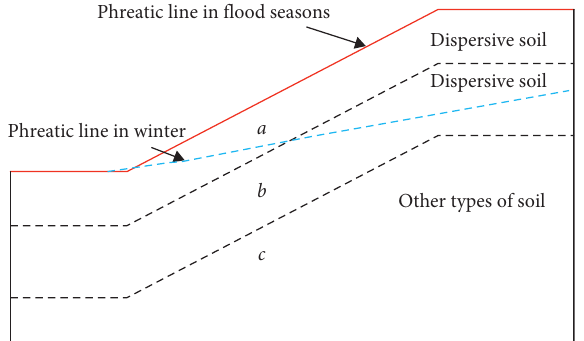
Figure 5: Layers of the dispersive soil slope.